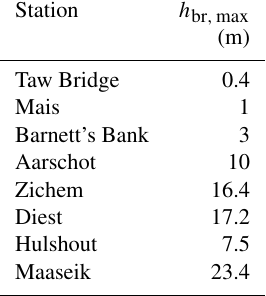
Table 2. Values for h br , max